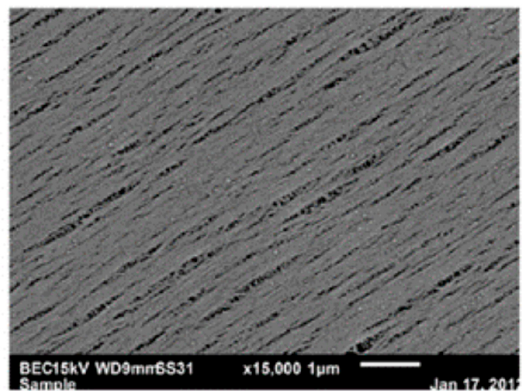
Figure 3. Electron microscopy of inner (blood-contacting) surface of the Polyflux polymer filter membrane at 15,000× showing the slit pores morphology (adapted from [160] with permission).